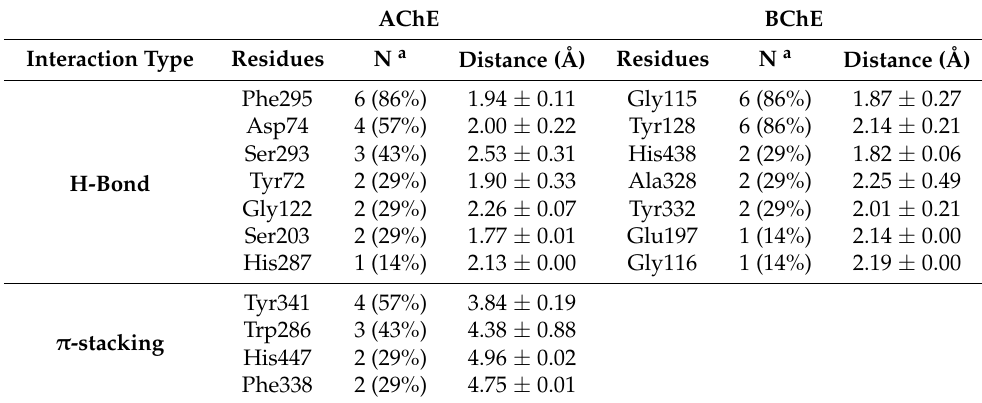
Table 2. Specific AChE/BChE–ligand interactions and their occurrence (%) and averaged distances, obtained from molecular docking